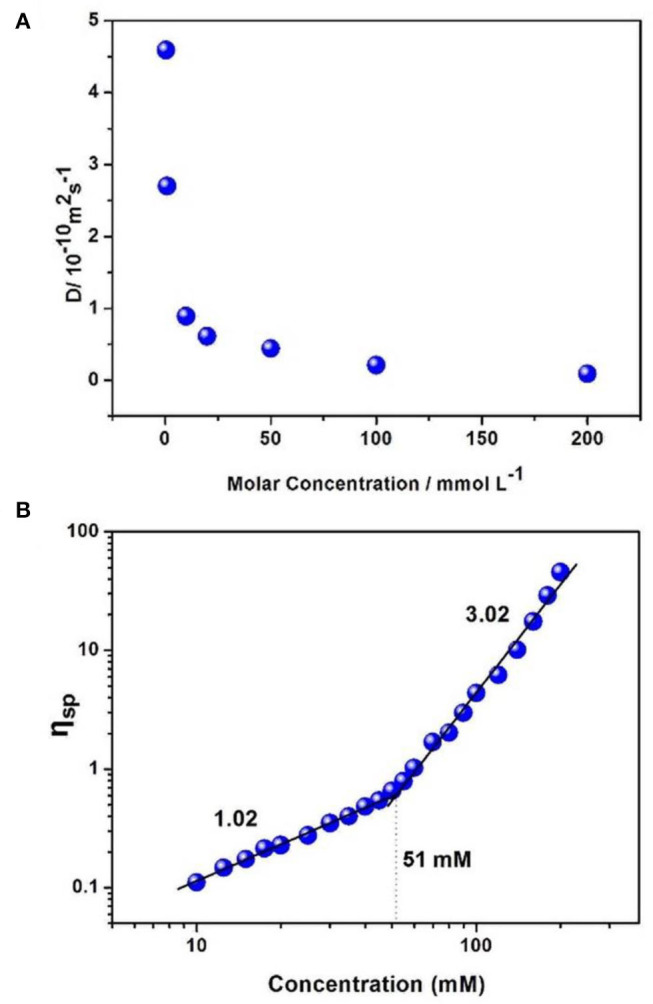
(A) Concentration dependence of diffusion coefficient D (500 MHz, CDCl3, 298 K) of [PdCl2(PhCN)2] and [2]pseudorotaxanes in a 1:1 molar ratio. (B) Specific viscosity of equimolar mixtures of [2]pseudorotaxanes and [PdCl2(PhCN)2] vs. the [PdCl2(PhCN)2]/[2]pseudorotaxanes concentration (DMSO, 298 K).